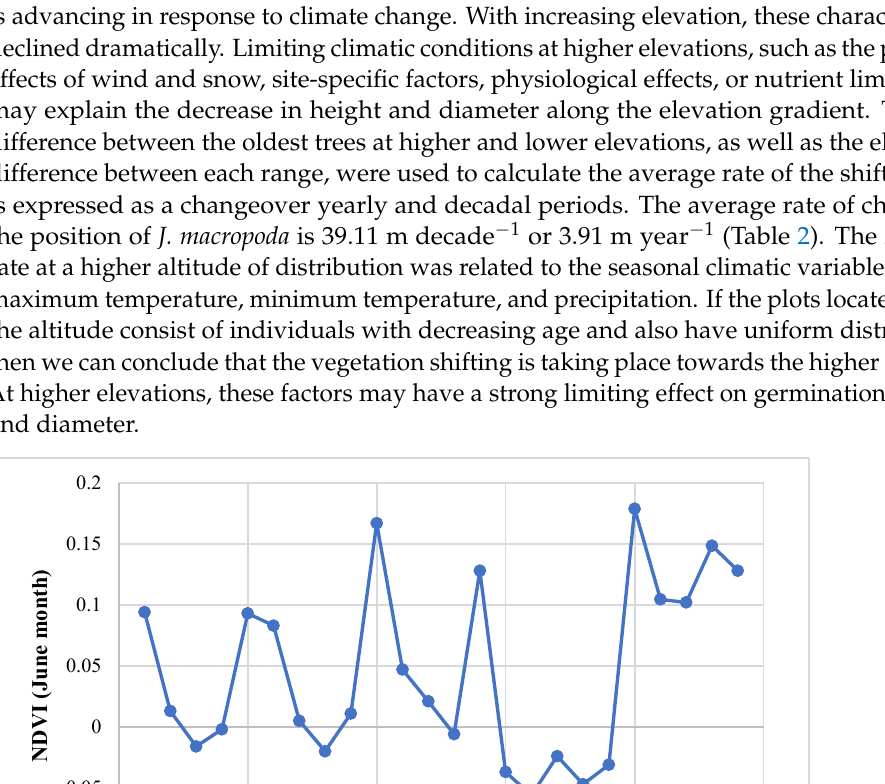
Table 1. The NDVI value change matrix from 1994 to 2017 in the study area.